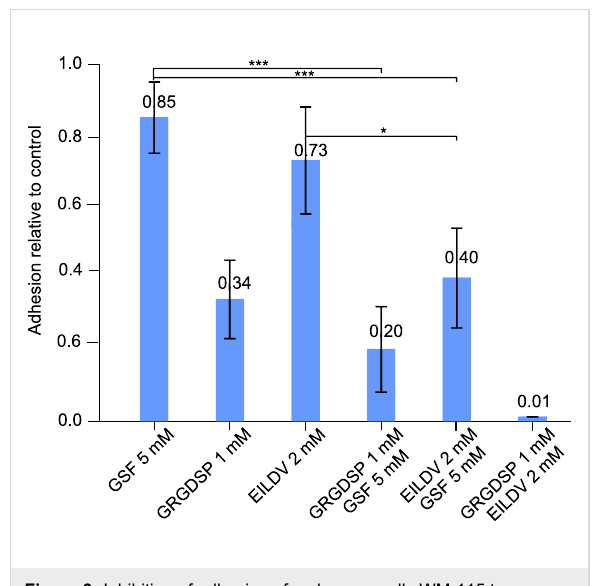
Figure 3: Inhibition of adhesion of melanoma cells WM-115 to fibronectin-coated plastic by 5 mM (4-{[( β -D- galactopyranosyl)oxy]methyl}furan-3-yl)methyl hydrogen sulfate (GSF), 1 mM glycine–arginine–glycine–aspartic acid–serine–proline (GRGDSP), 2 mM glutamic acid–isoleucine–leucine–aspartic acid–valine (EILDV), 1 mM GRGDSP plus 5 mM GSF, 2 mM EILDV plus 5 mM GSF, 1 mM GRGDSP plus 2 mM EILDV. Cells were radioactively labeled and incubated in the presence of the